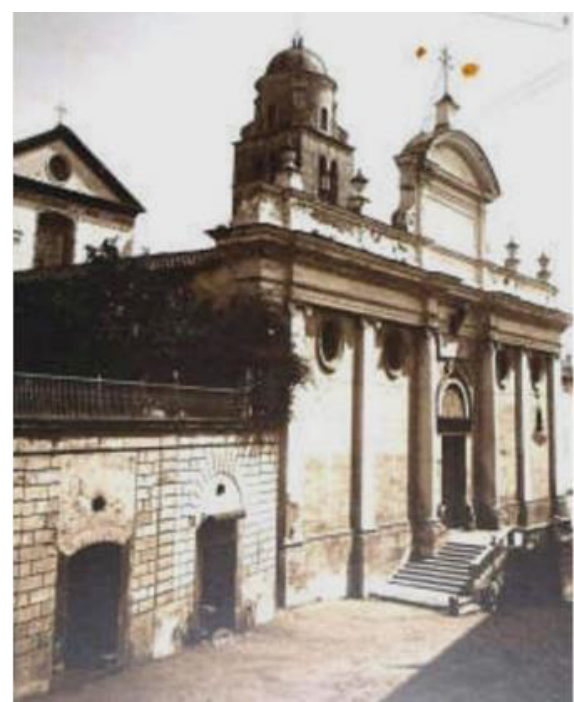
Figure 3. The facade of the Cathedral of San Matteo in Salerno before the restoration